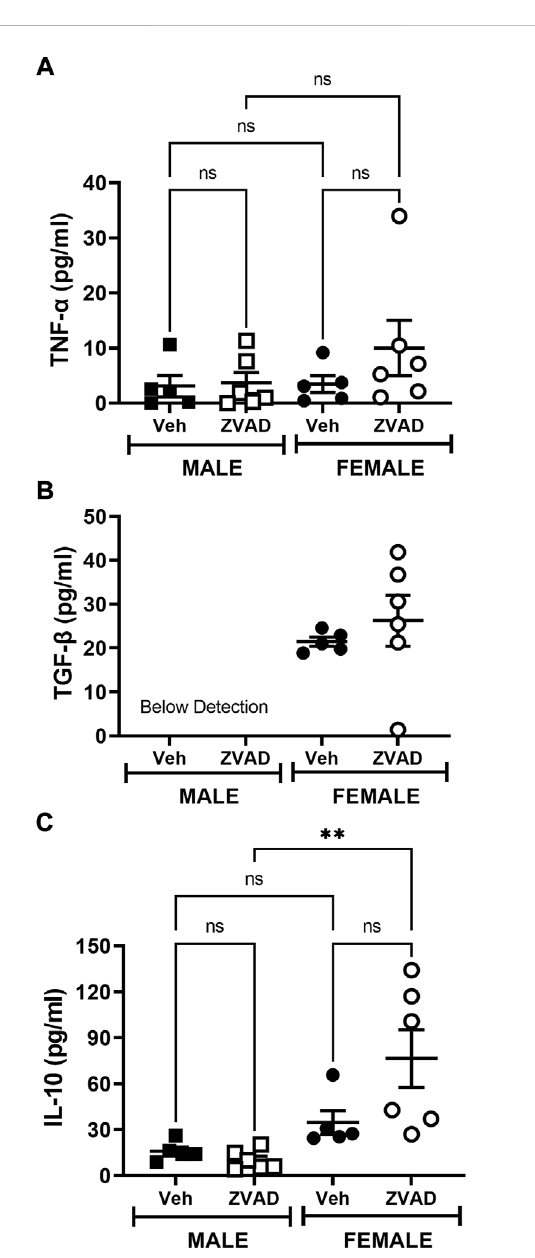
FIGURE 5 Treatment with ZVAD-FMK for 2 weeks does not increase circulating pro-in fl ammatory cytokines in male or female SHR. Circulating levels of TNF- α [panel (A) ], TGF- β [panel (B) ], and IL-10 [panel (C) ] were measured by ELISA in the plasma isolated from male and female spontaneously hypertensive rats (SHR) treated with vehicle (veh) or ZVAD-FMK (ZVAD) from 13 to 15 weeks of age ( n = 5 – 6). Data were compared using 2-way ANOVA followed by Tukey ’ s multiple comparisons test; ** indicates p < 0.01; NS indicates not signi fi